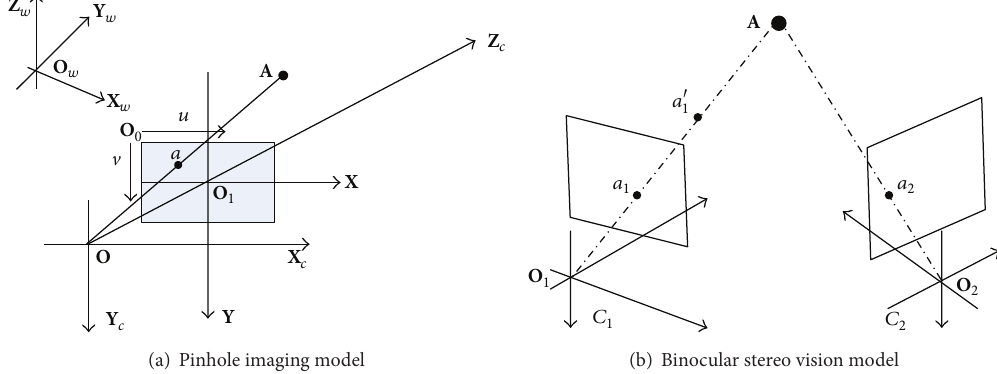
Figure 3: Pinhole imaging and binocular stereo vision model.